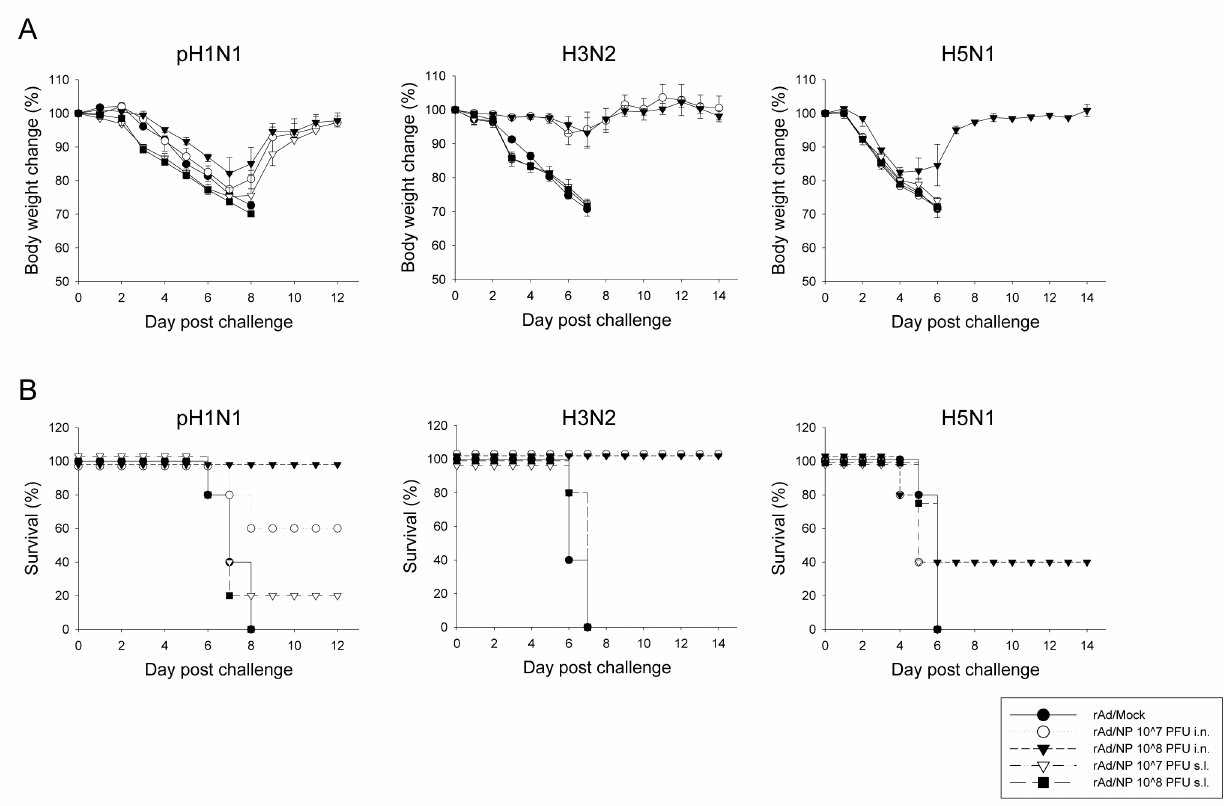
Figure 5. Analysis of protective efficacy against heterologous and heterosubtypic influenza virus challenge by mucosal rAd/NP vaccination. BALB/c mice were immunized intranasally or sublingually with 1×10 7 PFU or 1×10 8 PFU of rAd/NP. Control mice were immunized intranasally with rAd/Mock. Mice that received rAd/NP via sublingual route were boosted two weeks after the primary vaccination. Subsequently mice in all vaccination groups were challenged with 10 LD (H3N2) virus, or A/Vietnam (H5N1) virus. (A) Body weight and (B) survival rate were recorded daily. Error bars in weight loss graph indicated mean ± SEM of five mice per